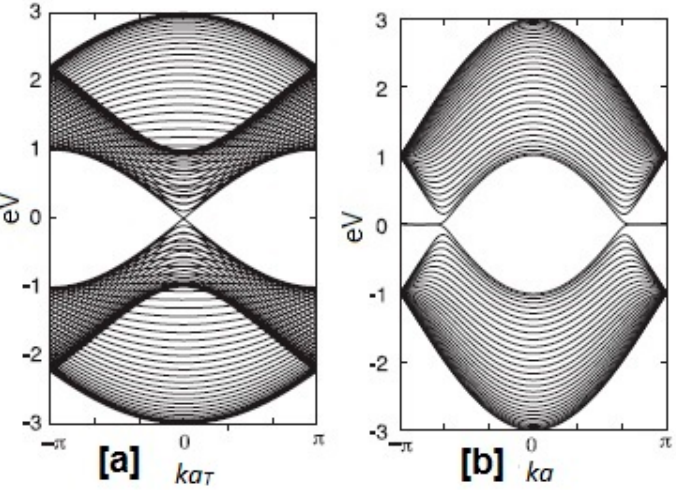
Figure 3. Energy band structure of ( a ) armchair nanoribbon with N = 50 and ( b ) zigzag nanoribbons with N = 30 [31]. Reproduced with permission from [31]. Elsevier, 2012.